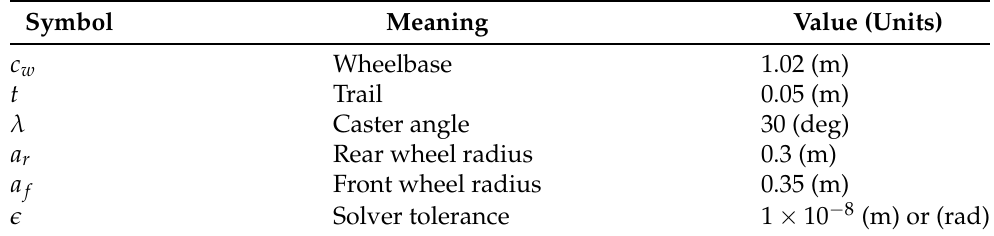
Table 1. Numerical values of the physical parameters employed in the numerical experiments. Symbol Meaning Value (Units)